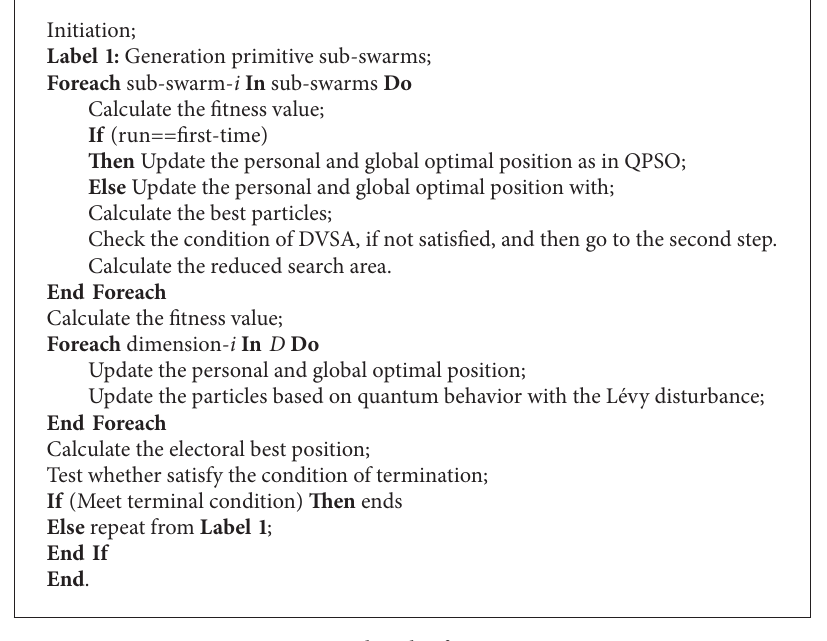
Algorithm 1: Pseudocode of CQPSO-DVSA-LFD.